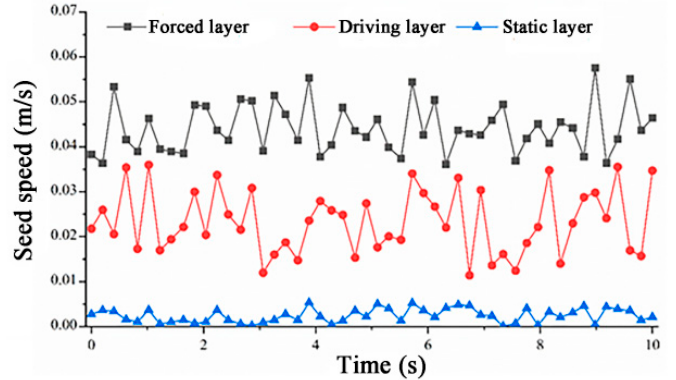
Figure 16. Variation of seed velocity in different layers. Evident movement of the seeds in the forced layer makes it easy to squeeze and collide between the seed and the seed as well as between the grooved wheel and the husk, resulting in damage to the seeds in severe cases, which often occurs in the working process of the traditional straight grooved wheels [27]. For this reason, the seed of the forced layer was selected as the research object to compare the seed stress changes under the working conditions of the traditional straight groove wheel and designed seed feeding wheel, as shown in Figure 17. The results show that the groove force of the new seed wheel is significantly smaller than that of the traditional straight groove wheel.